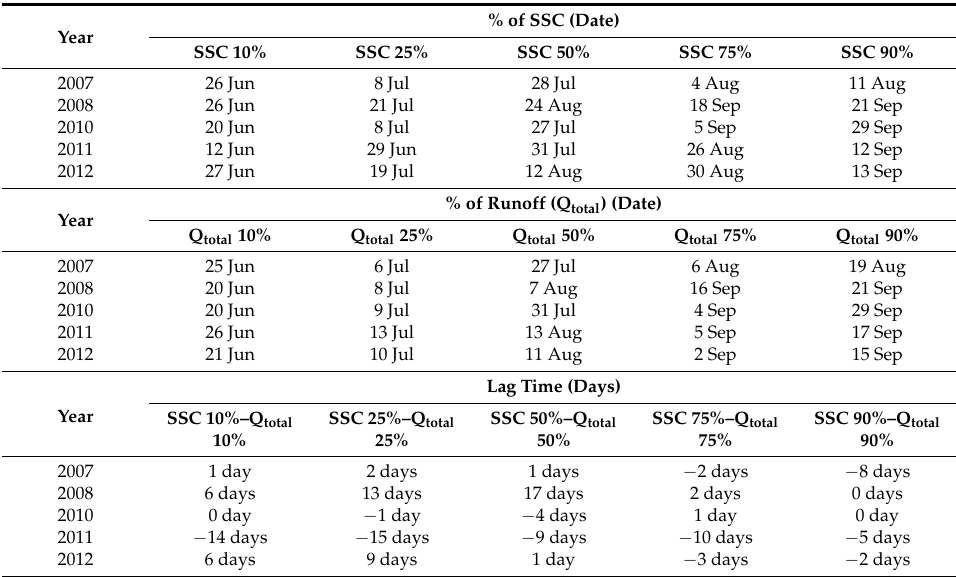
Figure 5. Cumulative delivery of SSL and Q. The suspended sediment load (SSL) is marked with a dashed line and runoff (Q total ) is a continuous line. Table 2. Dates and lag-times of the cumulative percentage distribution of suspended sediment concentration (SSC) and runoff (Q total ) for Breelva catchment.